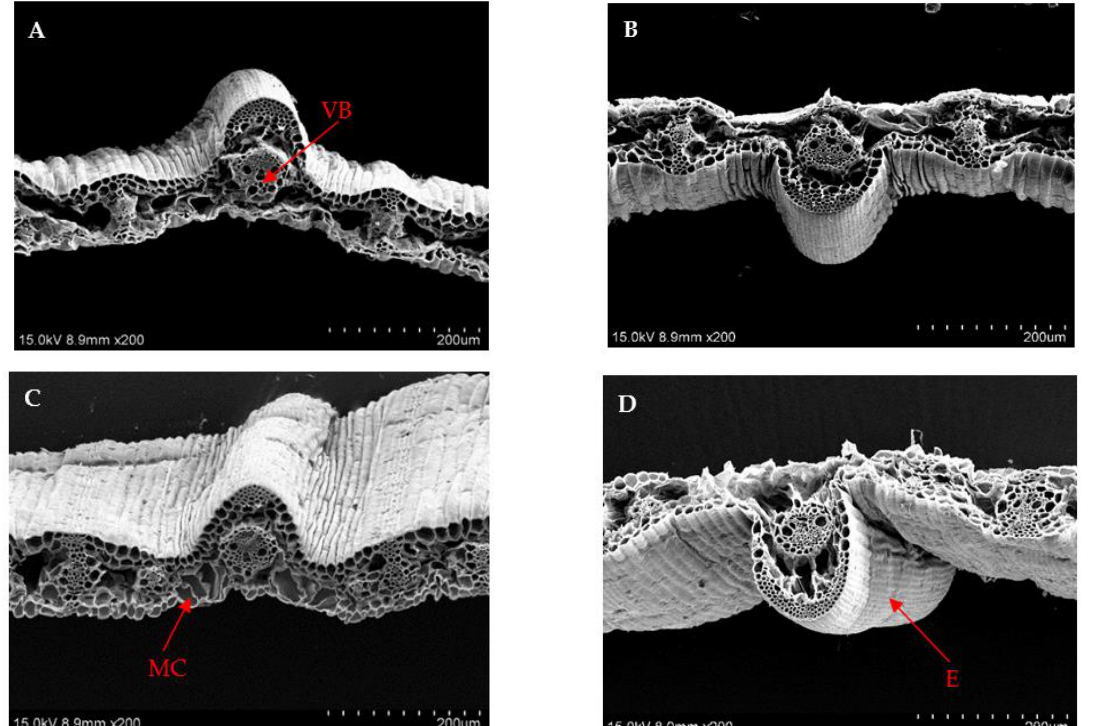
Figure 5. Leaf crosscutting structures of Kentucky bluegrass ramets in different patches under different water treatments (200×). ( A ) Homogeneous NS+ patch; ( B ) heterogeneous NS+ patch; ( C ) heterogeneous NS− patch; ( D ) homogeneous NS− patch; VB: vascular bundle; E: epidermis; MC: motor cell.